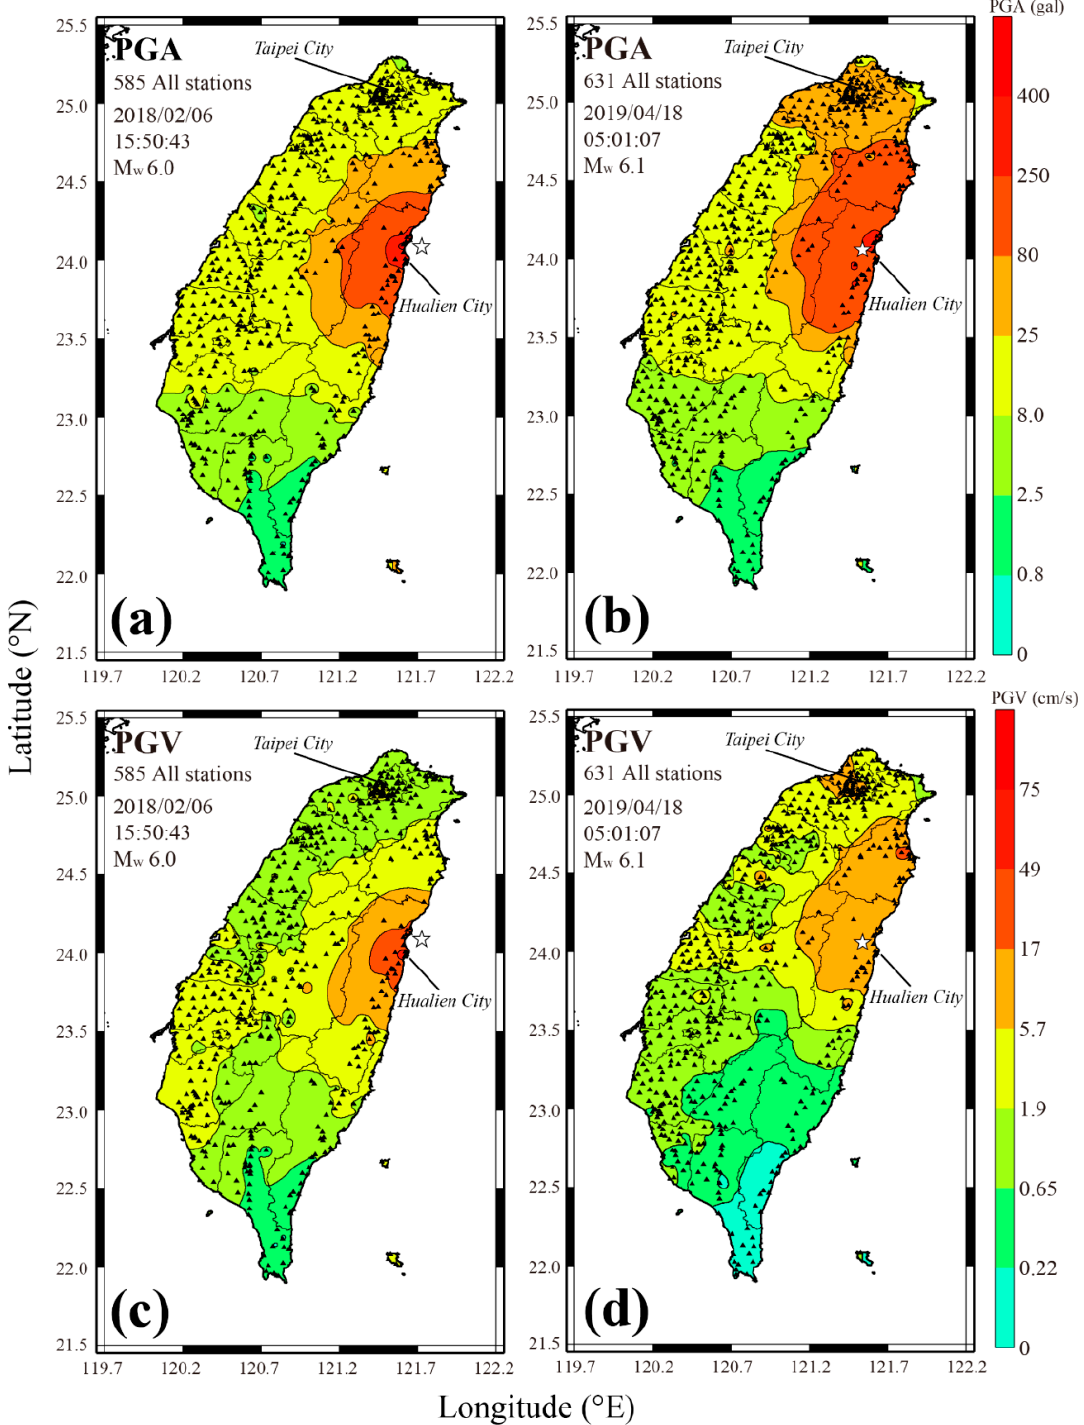
Figure 2. The distribution of PGA ( a , b ) and PGV ( c , d ) during the 2018 and 2019 Hualien earthquakes. Although, higher PGA values are obtained during both the earthquakes, the damage is concentrated in an area of high PGV.